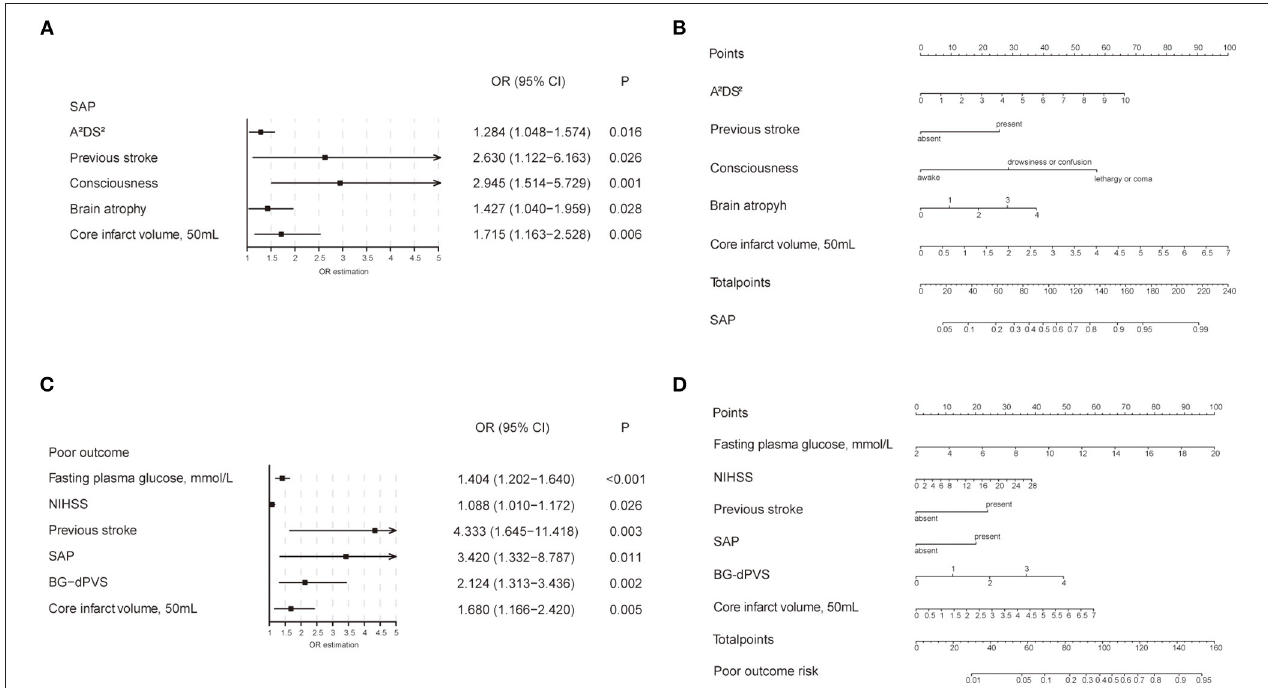
FIGURE 4 | Forest plot and nomogram of independent predictors of SAP and poor outcome. (A) Forest plot of independent predictors of SAP with a multivariate regression model. (B) The SAP model presented with a nomogram scaled by the proportional regression coefficient of each predictor. (C) Forest plot of independent predictors of poor outcome with a multivariate regression model. (D) The poor outcome model presented with a nomogram scaled by the proportional regression coefficient of each predictor. SAP, stroke-associated pneumonia; NIHSS, National Institute of Health stroke scale; BG-dPVS, basal ganglia dilated perivascular space; OR, odds ratio.